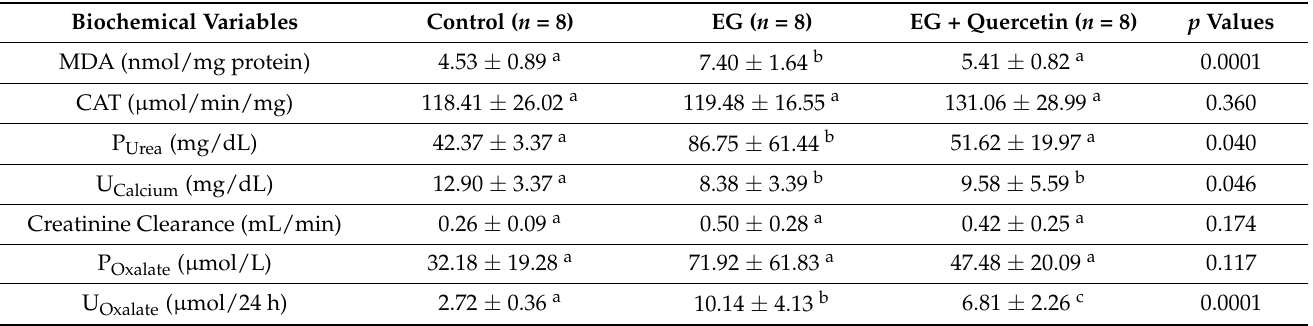
Table 1. Statistical data of the study groups and Duncan’s multiple range test